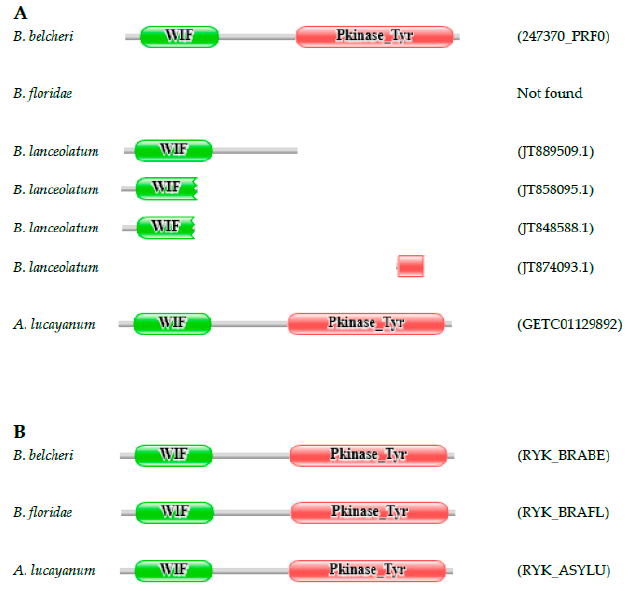
Figure 1. Ryk receptor tyrosine kinase genes are present in lancelet species. ( A ) Although the Branchiostoma belcheri genome encodes a full ‐ length Ryk receptor tyrosine kinase (247370_PRF0), no ortholog is found in the predicted proteome of Branchiostoma floridae . The transcriptome of Asymmetron lucayanum contains transcripts encoding full ‐ length Ryk receptor tyrosine kinase (GETC01129892.1), but in the case of B. lanceolatum , only fragments of the RYK gene are represented